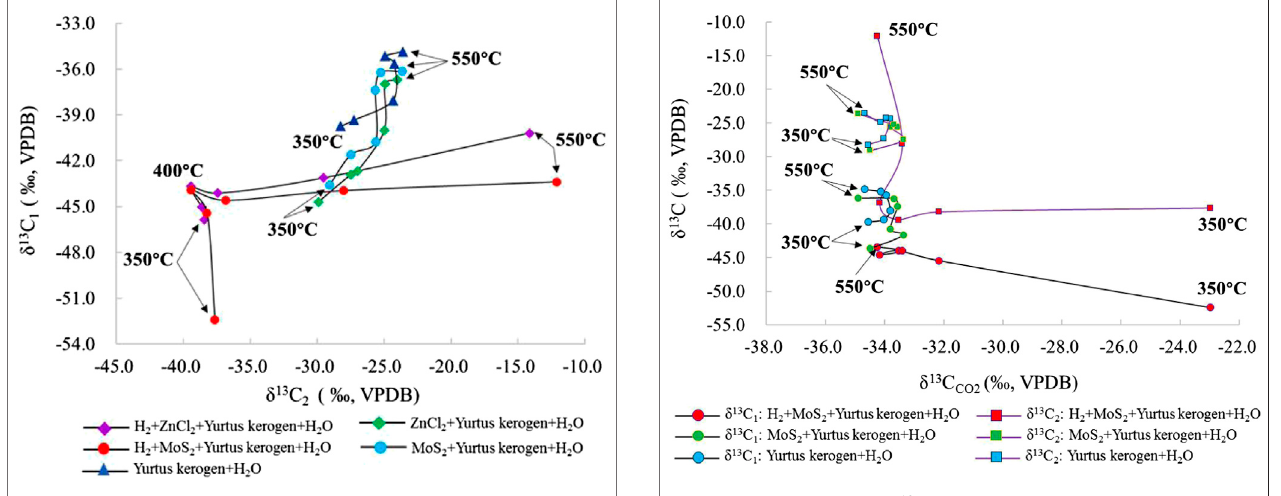
FIGURE 10 | Change in the δ 13 C 1 - δ 13 C 2 contrast simulated under different catalytic hydrogenation control conditions of the closed system.